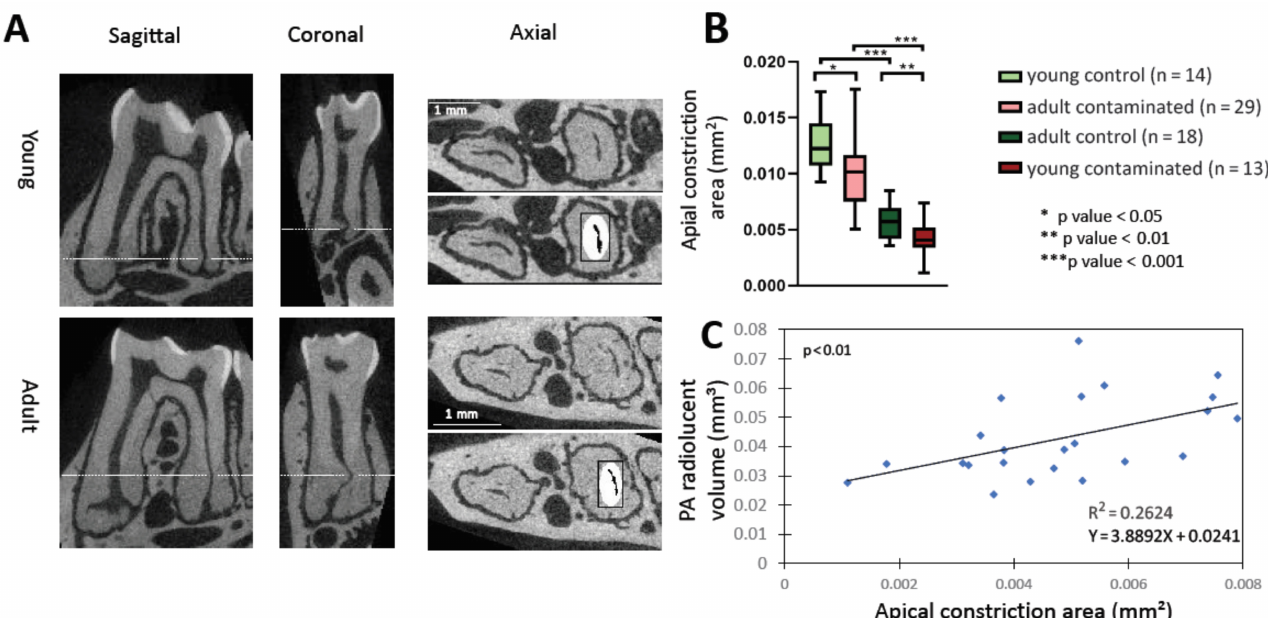
Figure 2. Apical constriction. ( A ) Representative micro-computerized-tomography (micro-CT) images of apical constriction measurement. Sagittal and coronal slices were used to assess the apical constriction location, which was then measured accurately on the chosen axial slice. ( B ) Apical constriction area for control and contaminated teeth of each age group ( n = 14 (young control), 13 (young contaminated), 29 (adult control), 18 (adult contaminated)) * p value < 0.05, ** p value < 0.01, *** p values < 0.001. ( C ) Linear correlation between the apical constriction area and the lesion volume (see Figure 5) for contaminated teeth (young and adult combined) up to 0.08 mm 2 (above this value the graph reaches a plateau—see Supplementary Figure